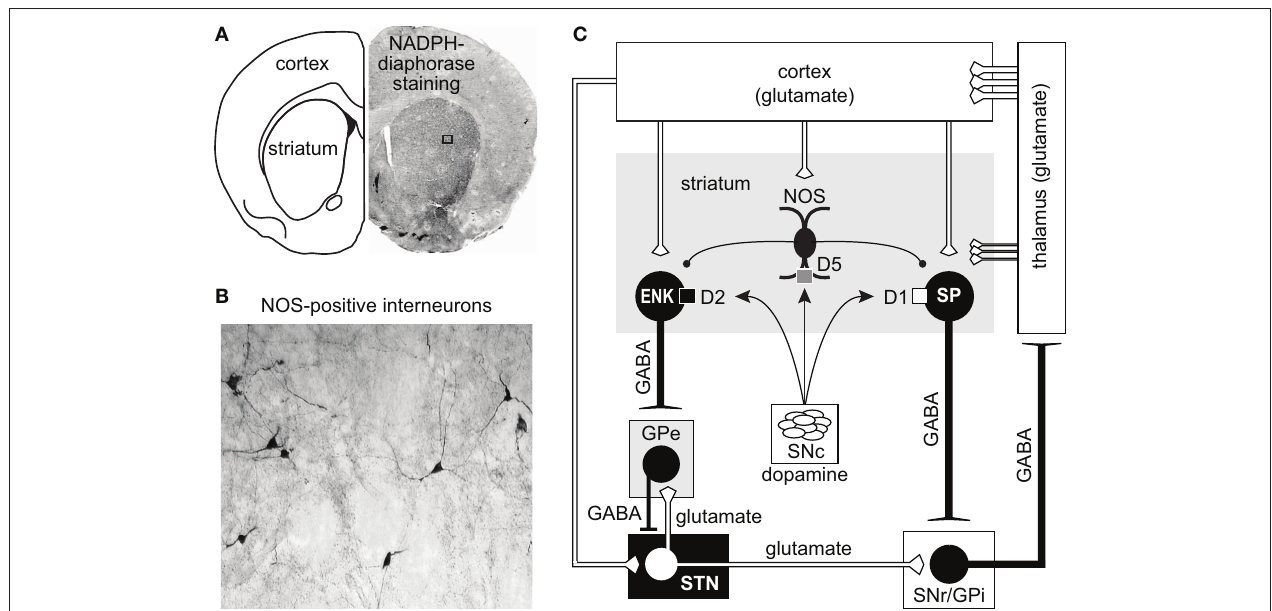
collaterals to the output nuclei of the basal ganglia: internal segment of the globus pallidus (GPi) and to the substantia nigra pars reticulata (SNr). Indirect striatal output neurons are indirectly connected to the GPi and SNr through connections that involve the external segment of the globus pallidus (GPe) and the subthalamic nucleus (STN). Feedback pathways to the cortex arise from GABAergic output neurons in the GPi and the SNr via the